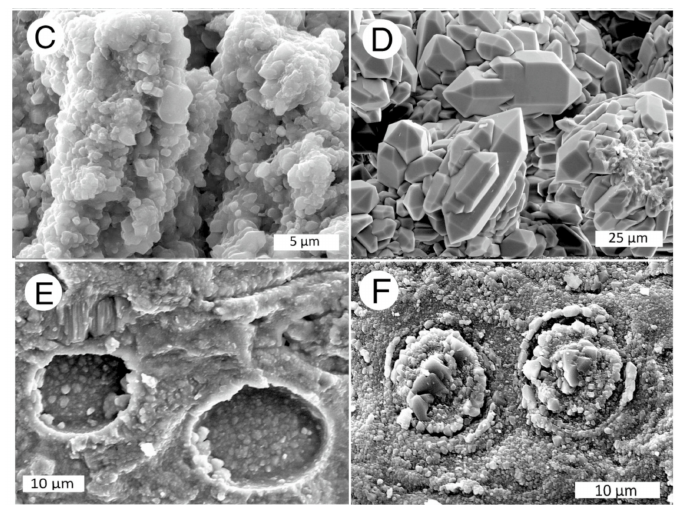
Figure 31. Megacrystalline quartz in fossil wood. ( A ) Longitudinal view of Late Pleistocene an- giosperm wood, Ban Tak, Thailand. Specimen courtesy of Nareerat Boochai. ( B ) Longitudinal view of Cretaceous wood, Trinity Formation, Texas, USA, ( C ) High magnification view of cells replaced by quartz. Cretaceous Kirtland Formation, New Mexico, USA. ( D ) Euhedral quartz crystals in Miocene wood, Black Rock Desert near Gerlach, Nevada, USA. ( E ) Small quartz crystals lining cell lumen, Cretaceous, Saskatchewan River, Canada. ( F ) Eocene wood from Yellowstone River, Montana, USA, showing crystalline quartz as pit casts in a cell wall replaced by granular quartz. The relatively large size of the crystals tends to reduce the fidelity of preservation of cellular details, compared to chalcedony-mineralized wood.